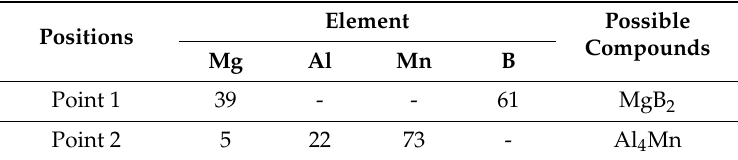
Element Possible